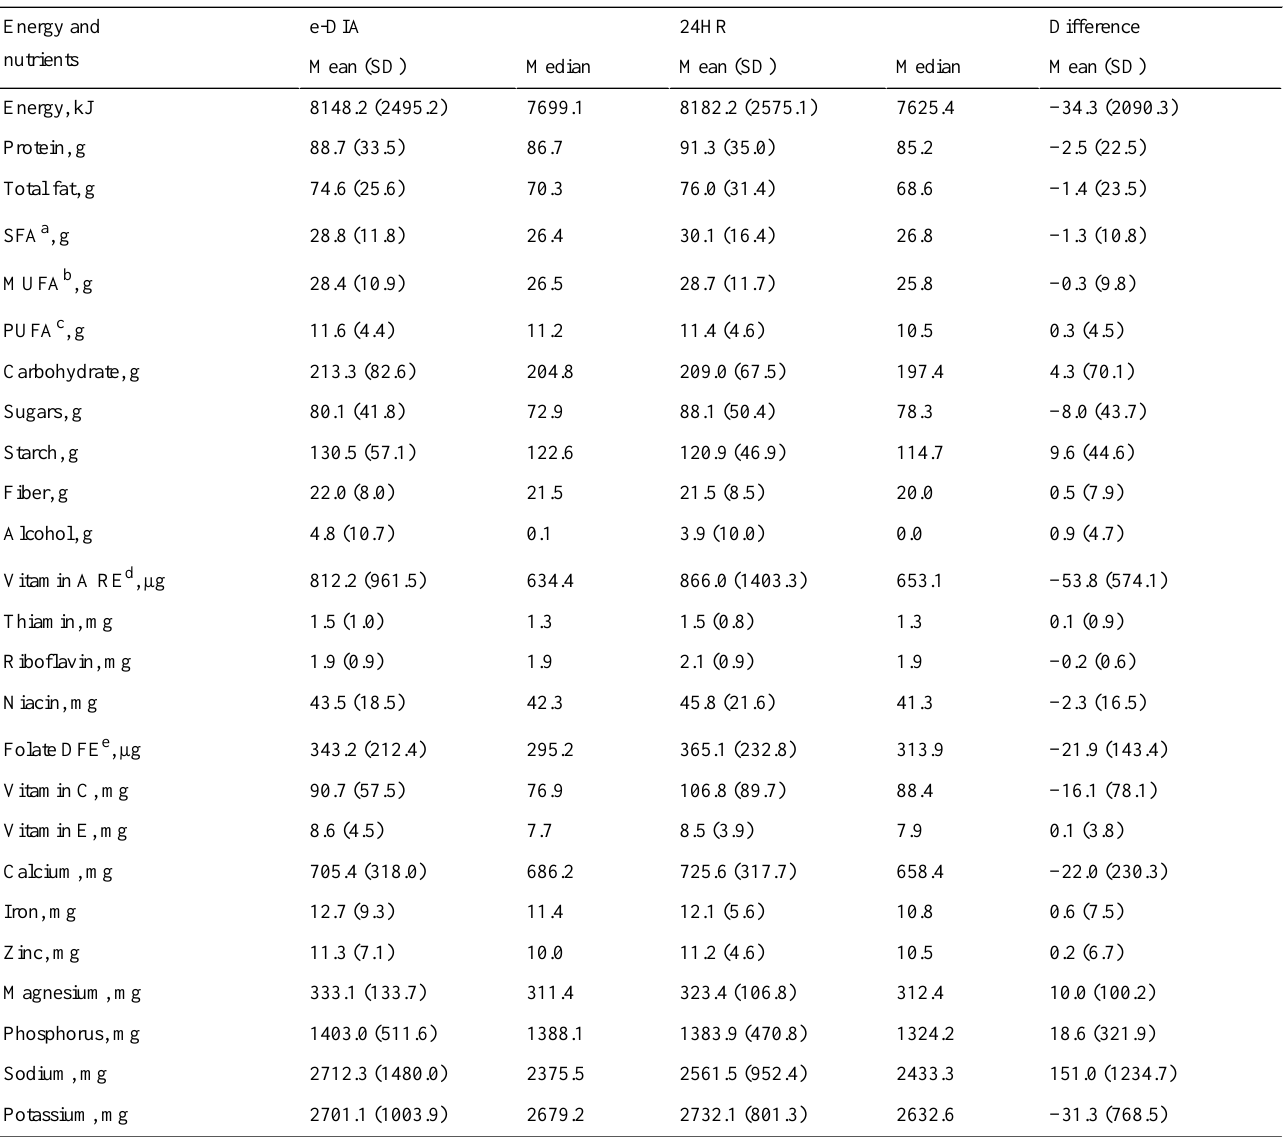
Table 1. Mean and median daily intakes of energy and nutrients measured by three days of 24-hour dietary recall (24HR) and five days of electronic Dietary Intake Assessment